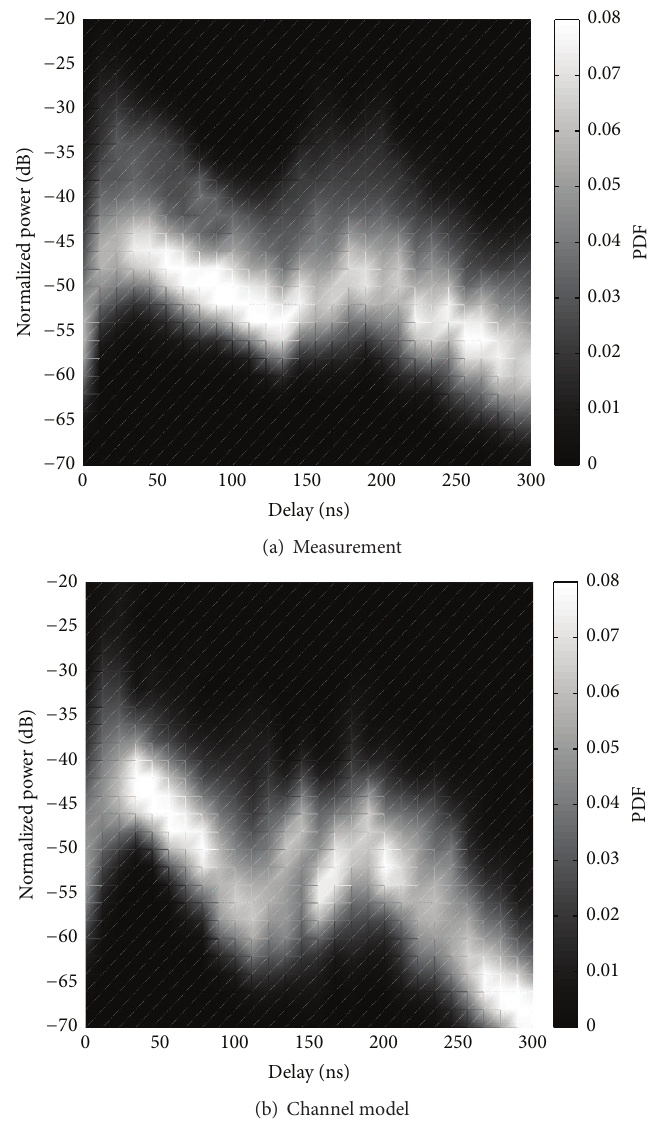
Figure 18: PDF of the normalized power on each delay bin for channel measurement and channel model. The PDP is normalized in power to the free space loss and shifted in delay to the